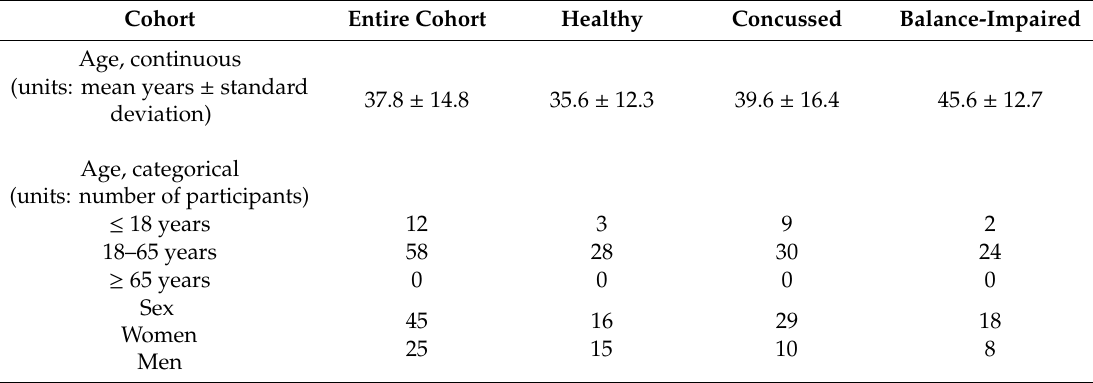
Table 1. Demographic descriptors of the cohort ( n =